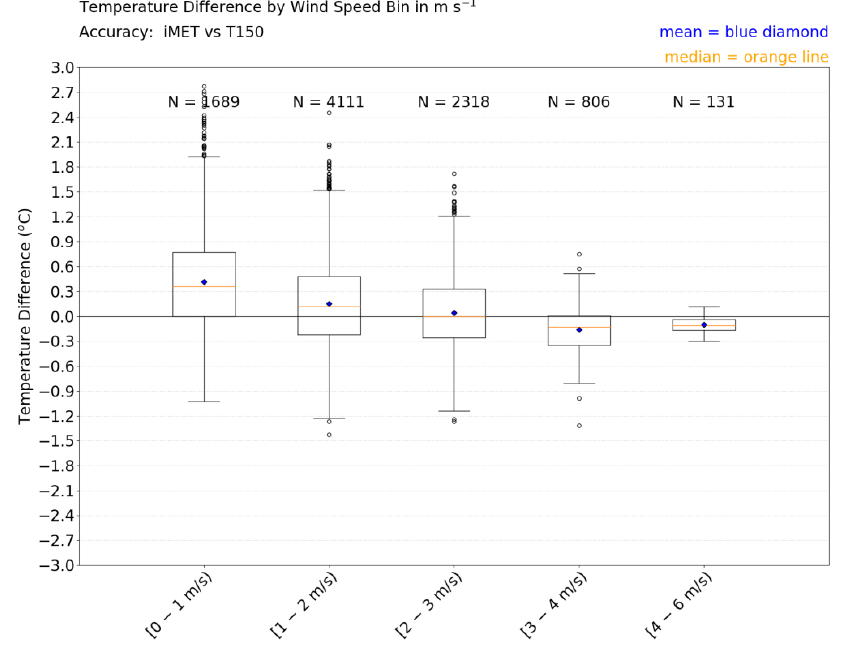
Figure 7. Side-by-side boxplots of the absolute values of the temperature differences (°C) between the iMET-XQ and 1.5 m tower temperature thermistor (T iMET − T Tower ), for each timestep and each iMET-XQ, by 1 m s − 1 wind speed bins. Sample size (N) for each bin is given above each boxplot.